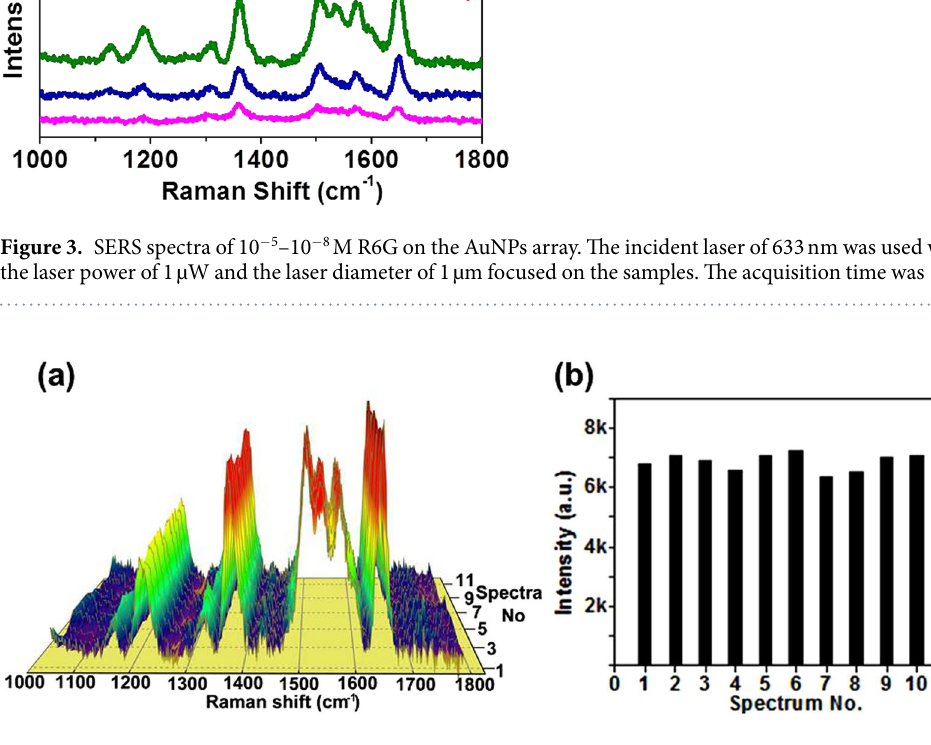
Figure 4. ( a ) Reproducibility of Raman spectra of 10 − 6 M R6G on the AuNPs array. Colors are assigned according to the relative intensity of the spectra. ( b ) Intensity distribution of the 1649 cm − 1 peak in the 11